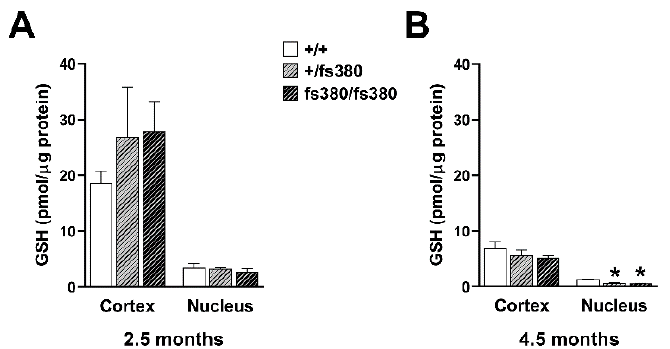
Figure 5. Levels of GSH in the cortex and nucleus of Cx46fs380 lenses. ( A , B ) Graphs show the levels of GSH in the lens cortex and nucleus from wild-type (+/+) and heterozygous (+/fs380) and homozygous (fs380/fs380) Cx46fs380 mice at 2.5 (A) and 4.5 (B) months of age. Data are presented as the mean (bar) + standard error of the mean (n = 3 for 2.5-month-old lenses and n = 4 for 4.5-month-old lenses). Asterisk denote a significant difference compared with wild-type littermates ( p < 0.05). GSH levels in the cortex of 4.5-month-old heterozygous and homozygous Cx46fs380 lenses were not different from wild-type ( p = 0.46 for wild-type vs. heterozygotes, and p = 0.25 for wild-type vs. homozygotes).